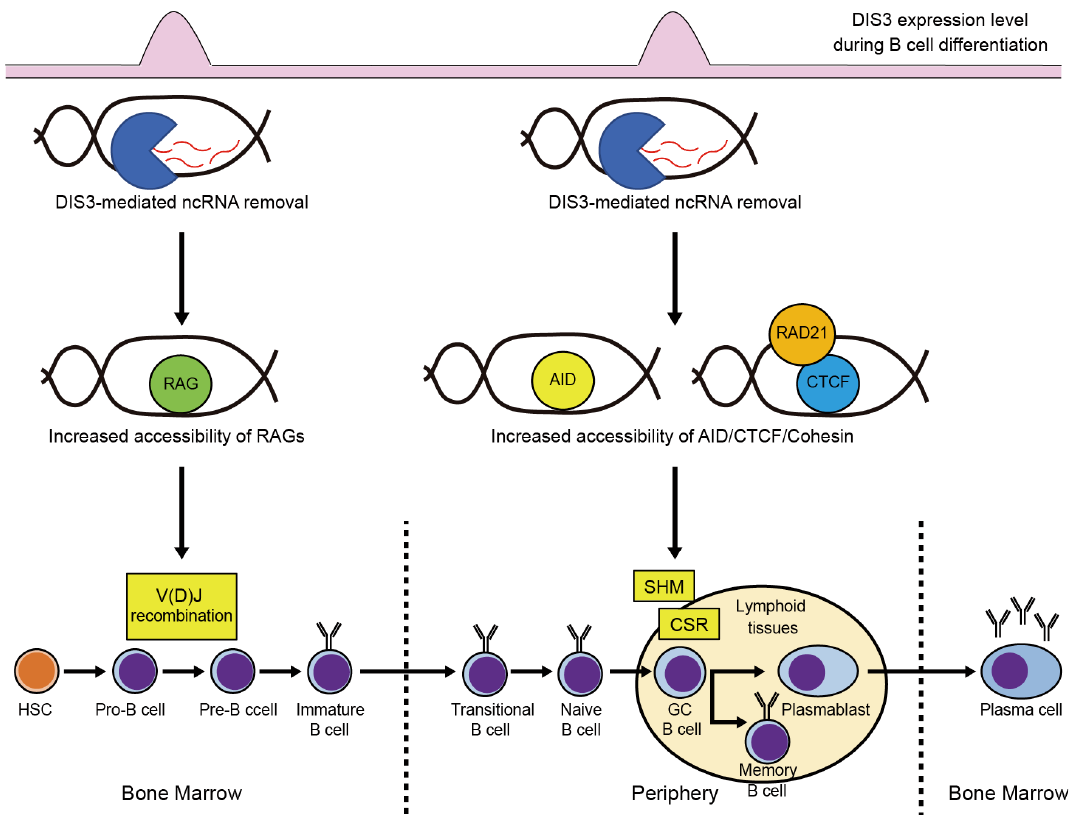
Figure 3. DIS3 is necessary for immunoglobulin gene rearrangements and B cell differentiation. Induced DIS3 removes noncoding RNAs (ncRNAs) to prevent the formation of DNA:RNA hybrids during immunoglobulin gene rearrangements, which increases the accessibility of RAG recombinases, activation-induced cytidine deaminase (AID), CTCF, and cohesin complex, leading to successful V(D)J recombination, somatic hypermutation (SHM), and class-switch recombination (CSR). HSC, hematopoietic stem cell; GCB cell, germinal center B cell.